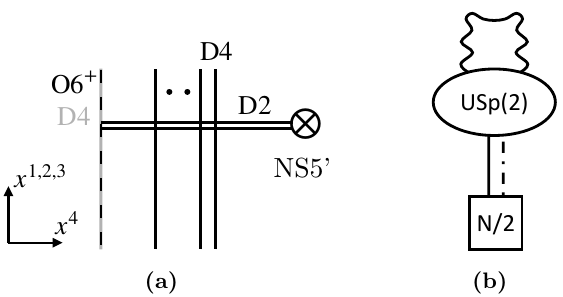
Figure 16. (a): the brane configuration for the monopole screening of the ’t Hooft operator in the 4d SO( N ) N = 2 ∗ theory, corresponding to ∧ 2 V , B = e n − 1 + e n , and v = 0 . The D4-brane on top of the O6-plane, indicted by the gray line, is present only for N = 2 n + 1 and not for N = 2 n . (b): the corresponding SQM quiver. The box with the symbol N/ 2 represents N